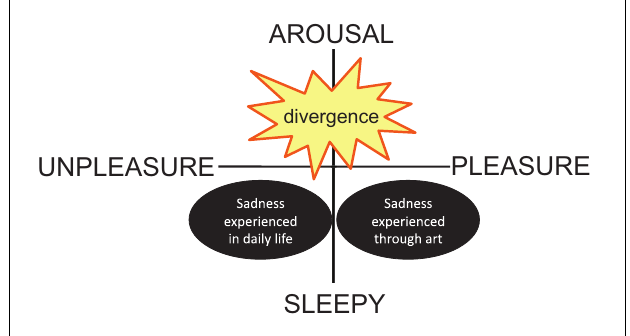
FIGURE 2 | The two kinds of